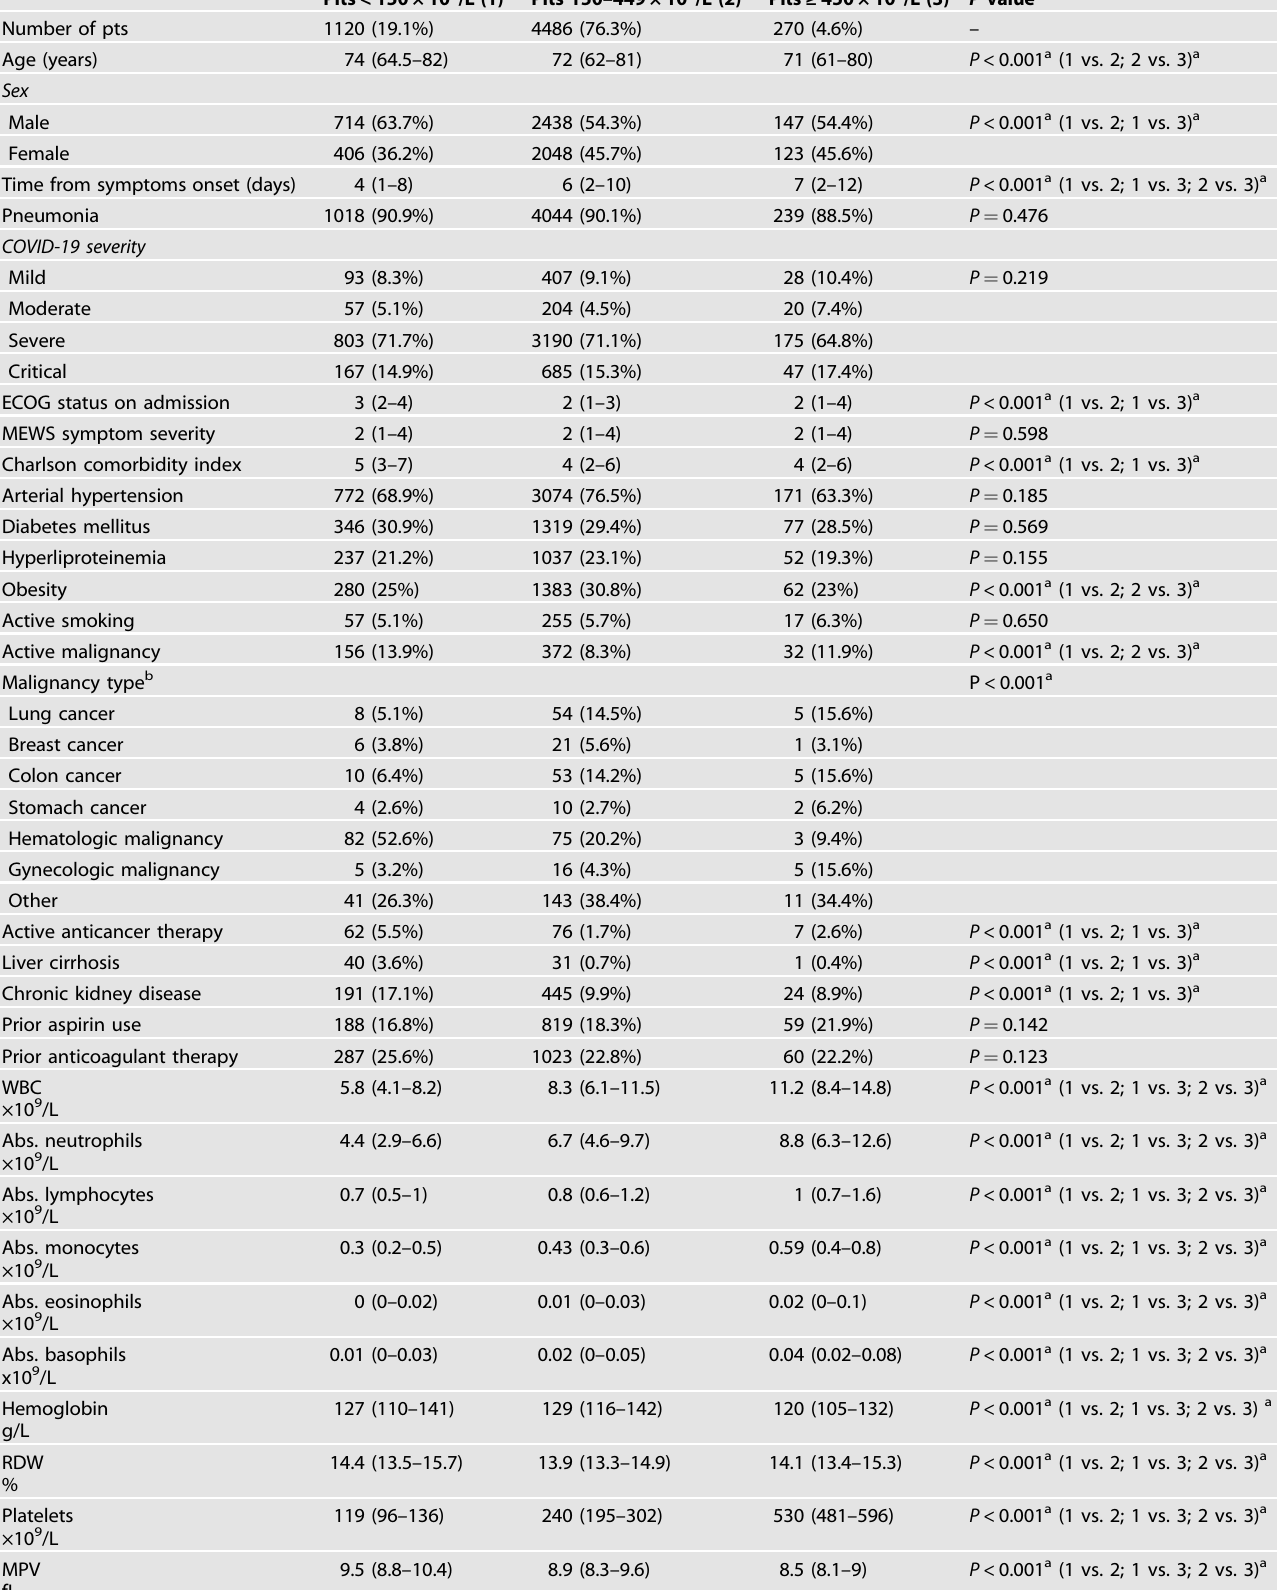
Table 1. Patients ’ characteristics on admission strati fi ed according to the baseline platelet